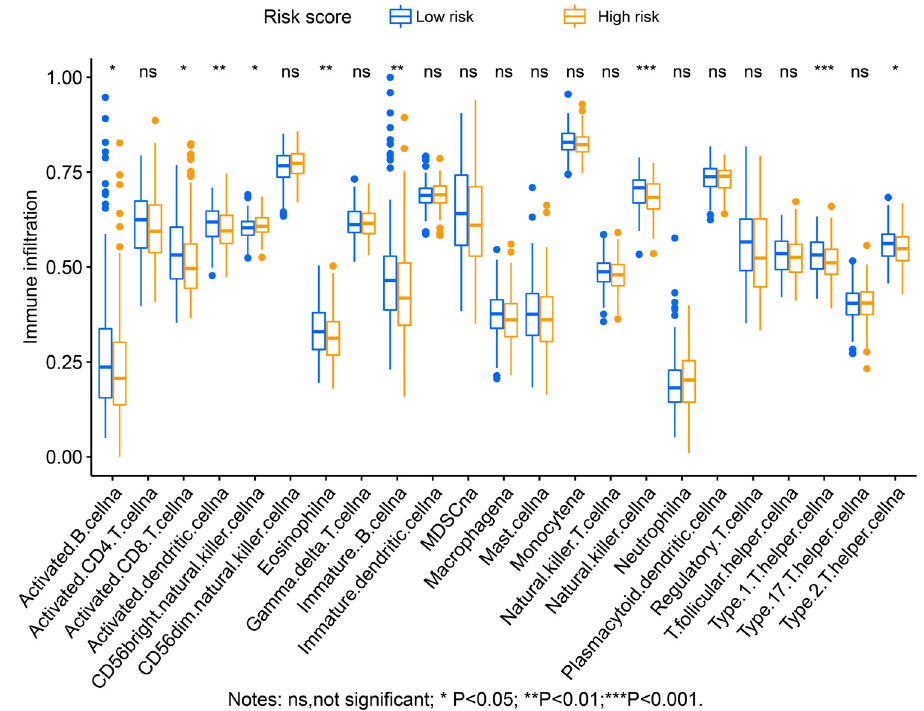
Figure 13: Immune in fi ltration analysis results of